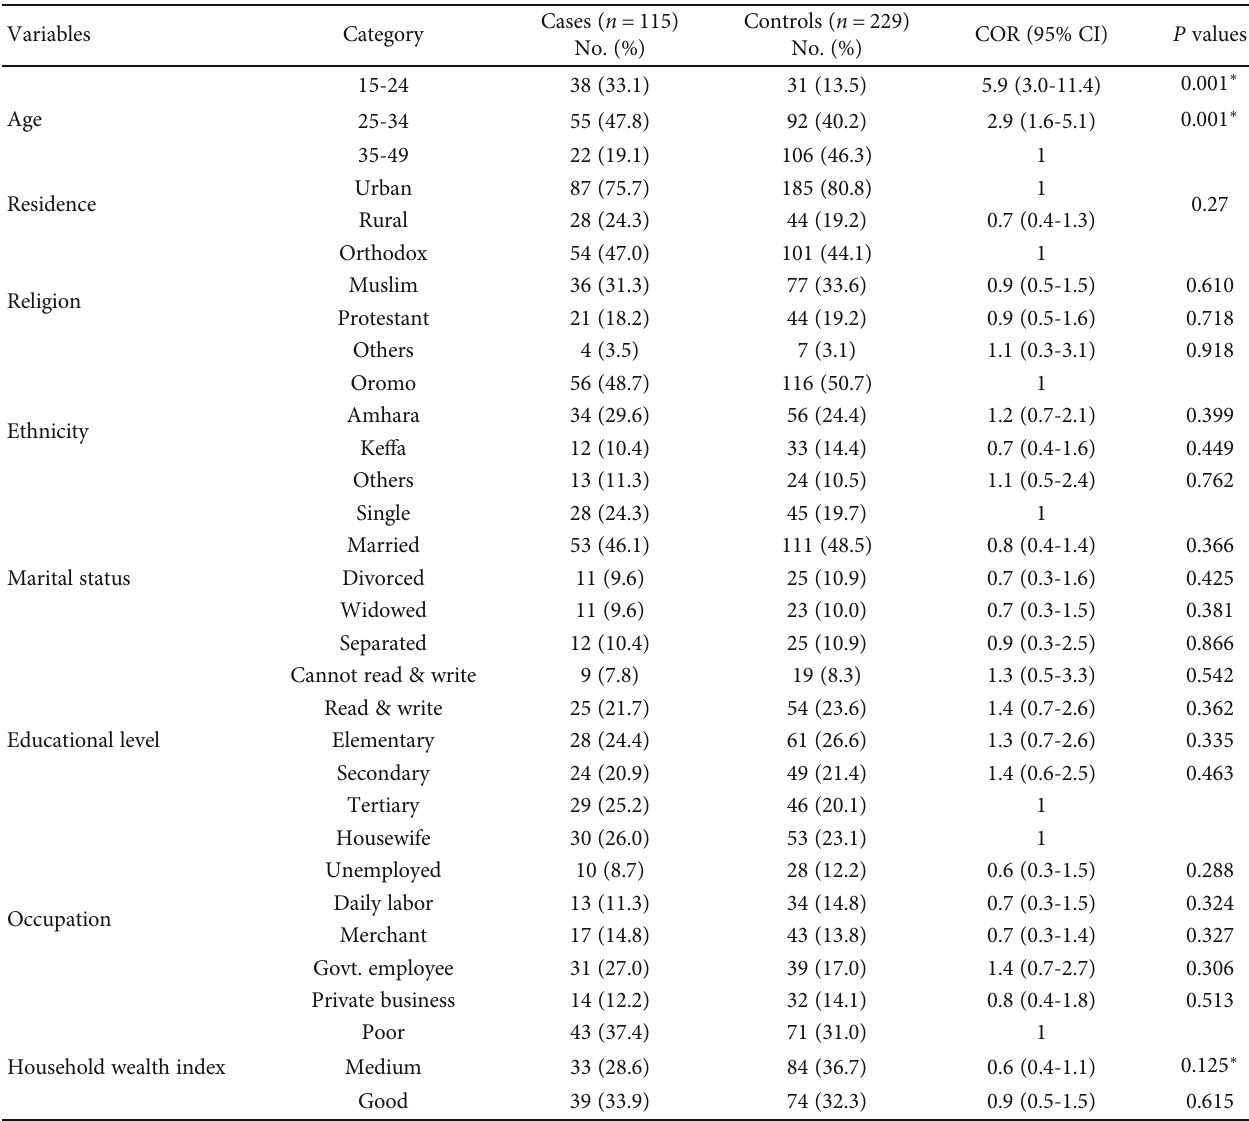
Table 1: Bivariate analysis of sociodemographic and economic characteristics of women living with HIV attending ART at Jimma University Medical Center, 2019 ( N = 344